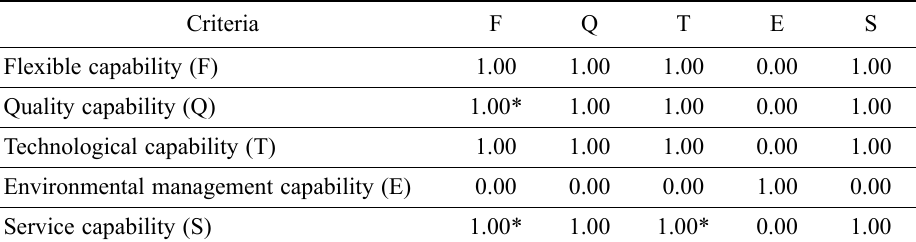
Table 6. Reachability matrix ( R * ) of all